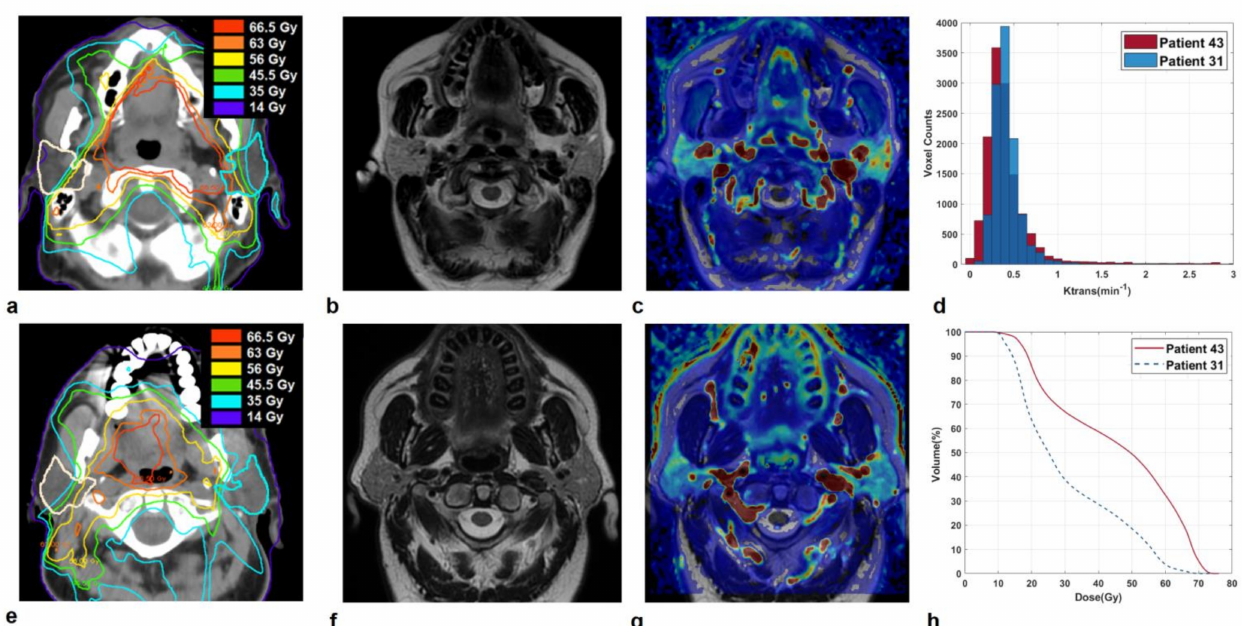
Figure 3. Sections of parotid glands in a 47-year-old woman affected by a base of the tongue carcinoma (Patient 43) on axial CT image with overlaid isodose levels and parotid contours ( a ); the corresponding axial T2-weighted image ( b ) and map of K trans ( c ). Analogously, sections of parotid glands in a 69-year-old man affected by a base of the tongue carcinoma (Patient 31) on axial CT image with overlaid isodose levels and parotid contours ( e ); the corresponding axial T2-weighted image ( f ) and map of K trans ( g ). K trans histograms ( d ) and dose-volume histograms ( h ) of both parotids, in